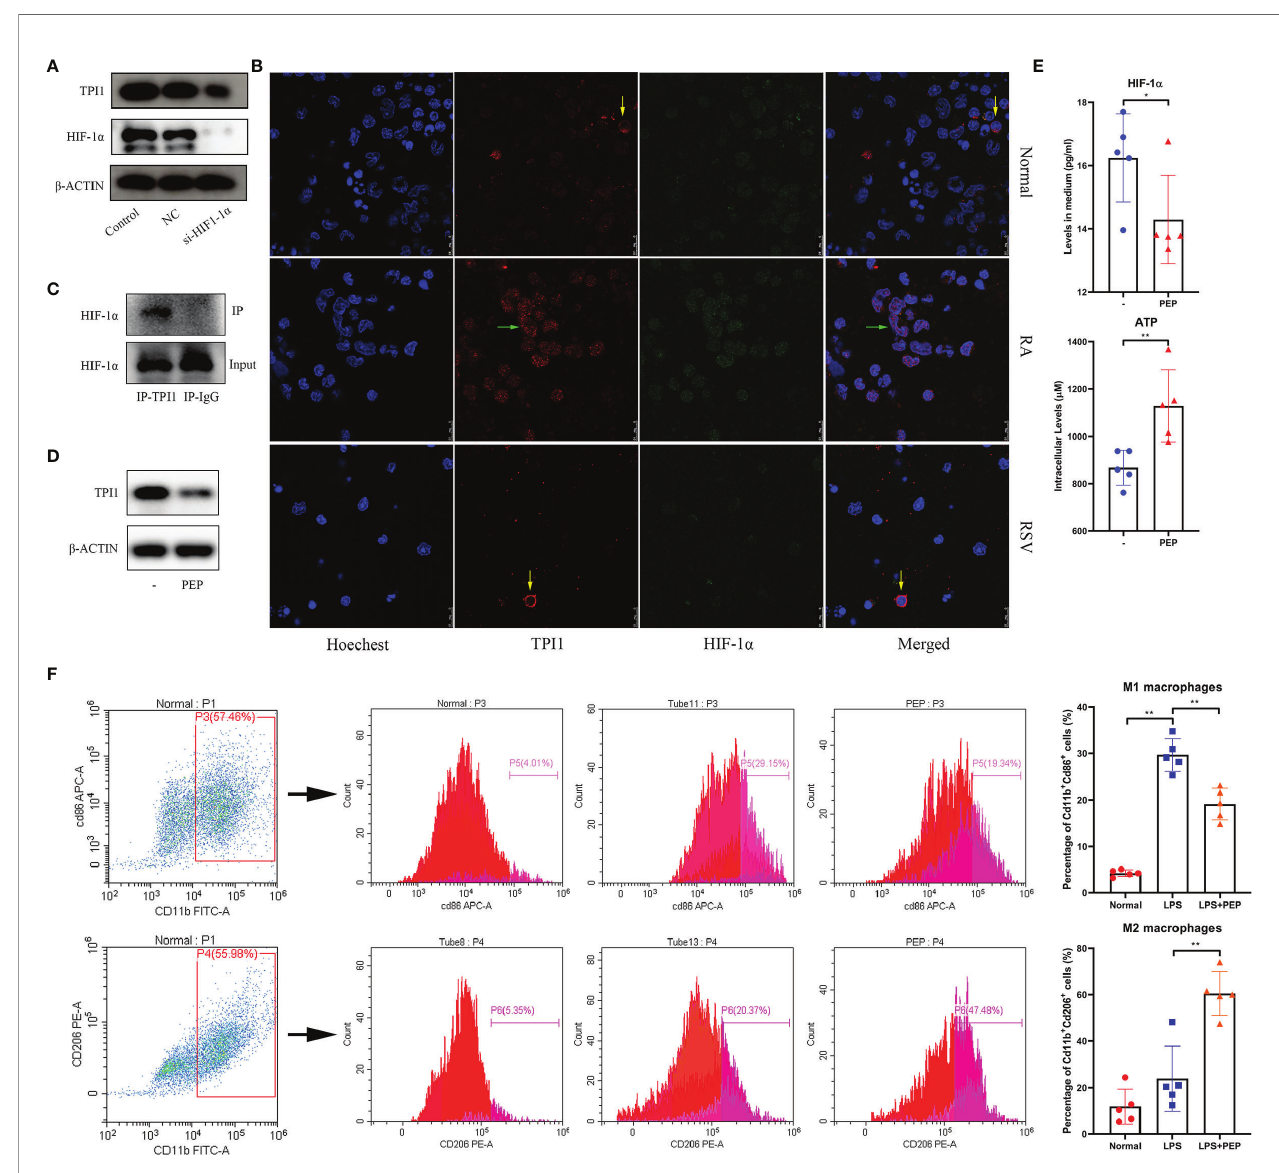
FIGURE 9 | Reciprocal interactions between TPI1 and HIF-1 a . (A) HIF-1 a silencing impaired TPI1 expression in RA monocytes; (B) expression and co-localization of TPI1 and HIF-1 a in normal and RA monocytes observed by immuno fl uorescence approach, some RA monocytes were treated by anti-hypoxia reagent RSV; (C) interaction between TPI1 and HIF-1 a in RA monocytes revealed by Co-IP experiment; (D) TPI1 inhibitor PEP decreased TPI1 in RA monocytes cultured in vitro ; (E) effects of PEP on intracellular ATP production and HIF-1 a excretion in RA monocytes; (F) PEP inhibited M1 polarization of mouse peritoneal macrophages, revealed by fl ow cytometry analysis. The statistical signi fi cance p values < 0.05* or 0.01** were calculated between groups matched by